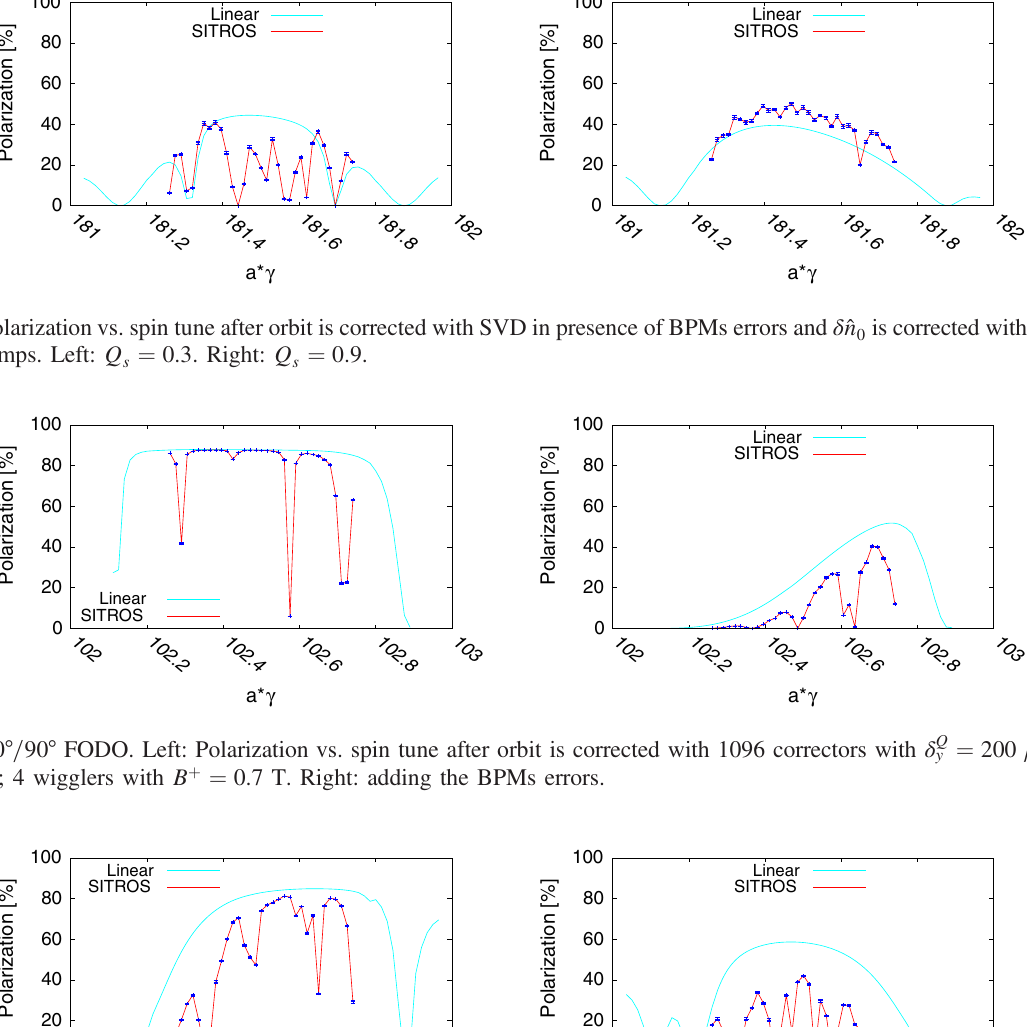
FIG. 14. 90 ° = 90 ° FODO. Left: Polarization vs. spin tune after orbit and δ ˆ n 0 correction with δ Q y ¼ δ M BPMs calibration error; 4 wigglers with B þ ¼ 0 . 7 T (45 GeV). Right: Polarization vs. spin tune after orbit and δ ˆ n 0 correction